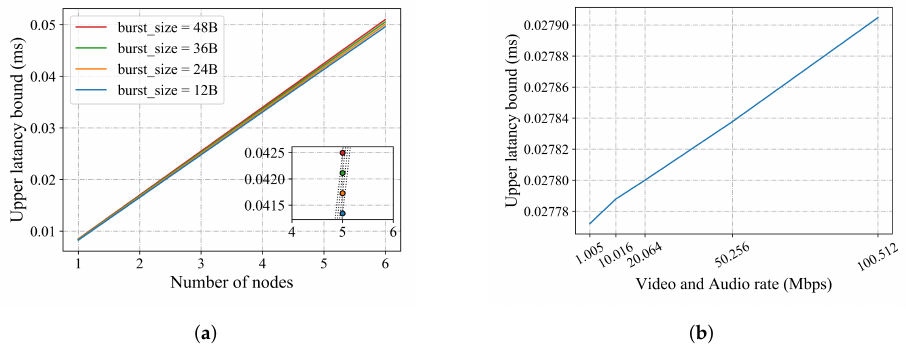
Figure 6. Delay upper bound influence factor: ( a ) number of Tactile Internet nodes, and ( b ) arrival rates of interference flow (when the number of nodes is